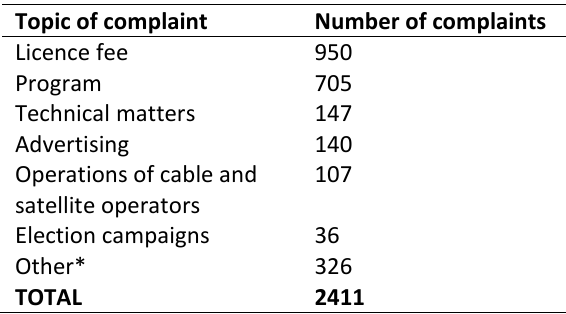
Table 1. Number and topics of complaints submitted to the National Broadcasting Council in